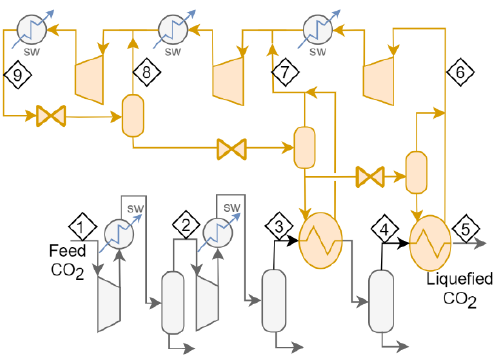
Figure 2. Flow scheme for Case 5a. In Case 5b, each of the three letdown valves is replaced with an expander.